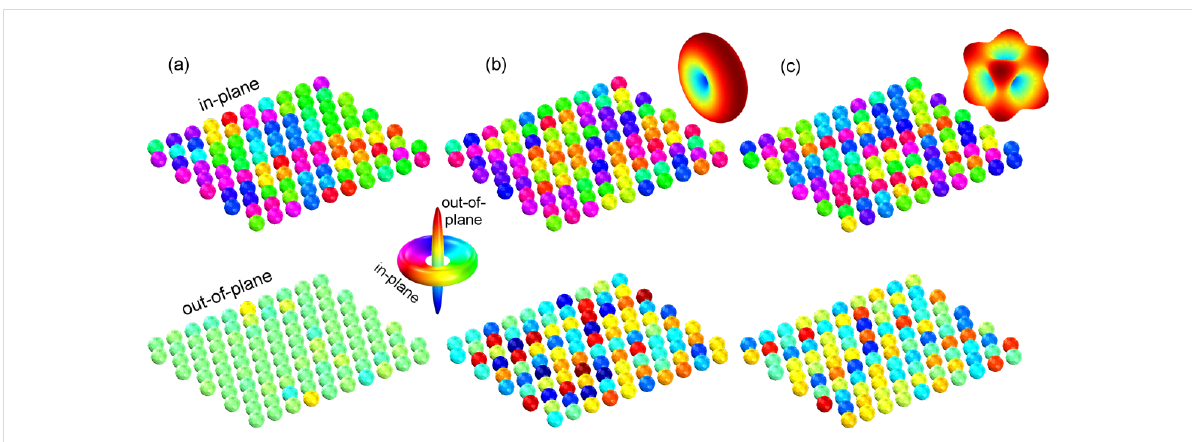
Figure 5: Equilibrium state of the model system. Particles of 13 nm size assembled in a hexagonal lattice with a grid constant of 18 nm and a satura- tion magnetization of M S = 900 kA/m. Subplots show different anisotropy scenarios: (a) amorphous, (b) uniaxial and (c) cubic magnetocrystalline anisotropy. The surfaces in the upper-right corner of (b) and (c) represent the angular energy distribution of the respective anisotropy scenario where blue areas correspond to energy minima (easy axes) and red to maxima (hard axes). The upper plots present the in-plane component of the magnetic moments (color-code: disc), the lower ones the out-of-plane component (color-code: cone).